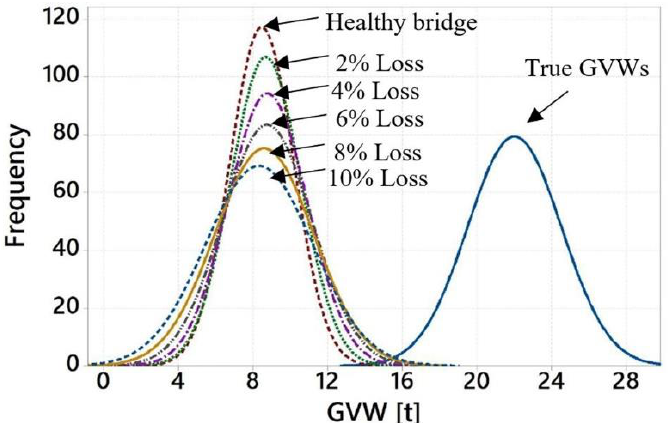
Figure 9. Normal distribution curves fitted to inferred GVWs using a half-car model using the class ‘A’ road profile with different percentage losses of stiffness.